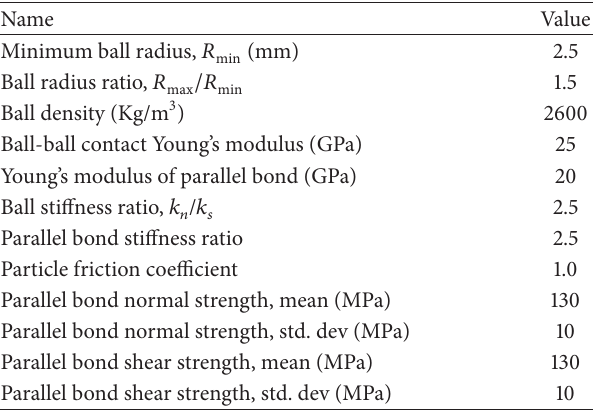
Table 2: Microscopic parameters of PFC3D